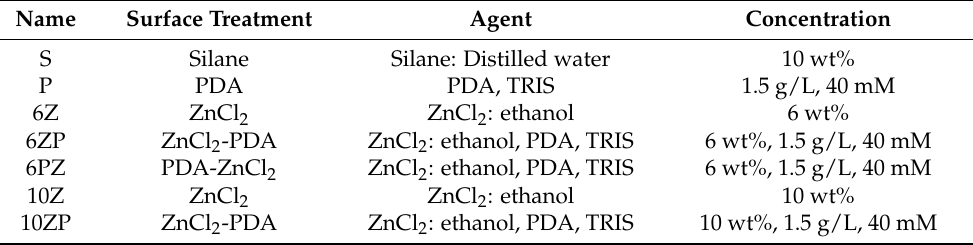
Figure 1. Schematic of the surface modification methods of aramid fiber. Table 2. Condition of chemical